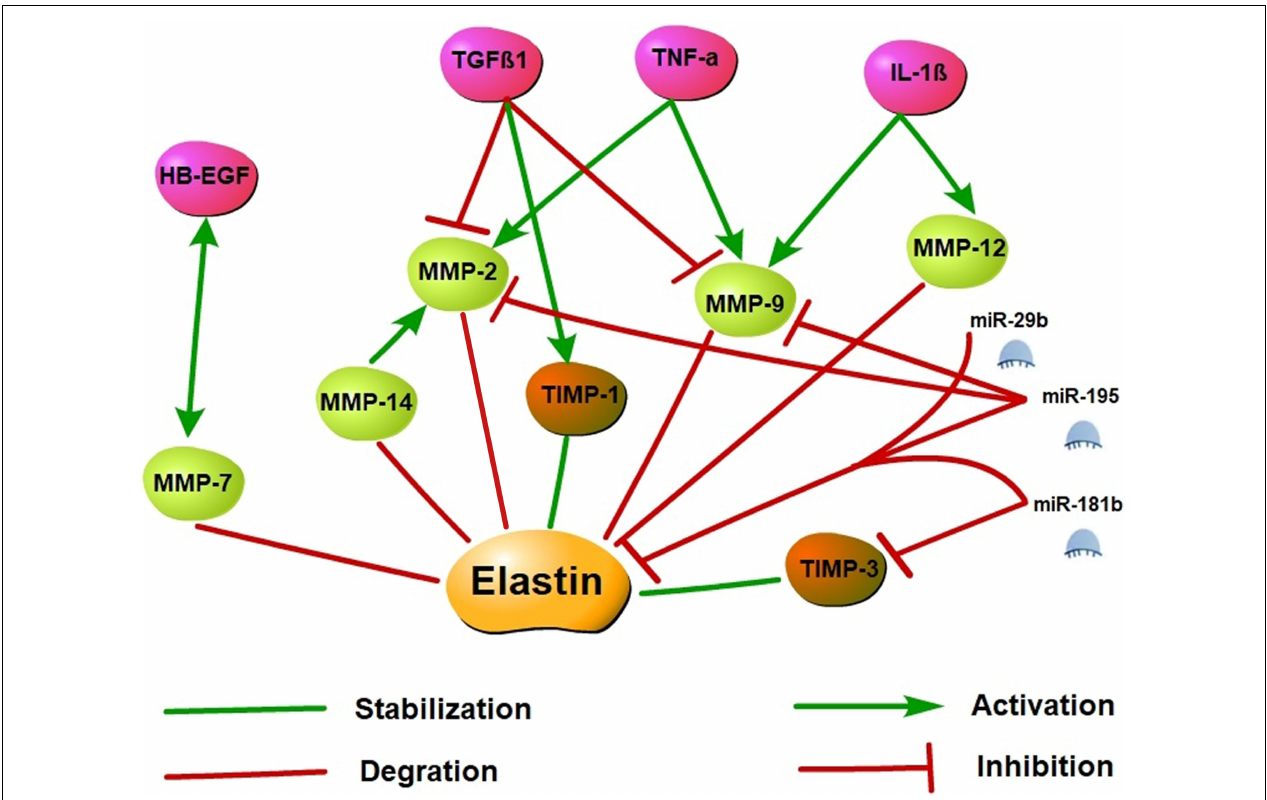
FIGURE 3 | Elastin synthesis molecular regulatory networks. Elastin synthesis is dynamically regulated by a variety of molecules. Activated MMP may promote the degradation of elastin and its precursor tropoelastin, while the increase of TIMP may stabilize the synthesis of elastin. TNF- α , IL-1 β , and HB-EGF may stimulate MMP activation and inhibit TIMP to induce elastin degradation. However, TGF β 1 may inhibit MMP activation and stimulate TIMP expression to suppress elastin degradation. Additionally, miR-29b, miR-195, and miR-181b are epigenetic regulatory molecules of elastin. These miRNAs may inhibit elastin expression by targeting the 3 (cid:48) UTR of ELN mRNA, and restrained MMP and TIMP activity to involve in the regulation of elastin